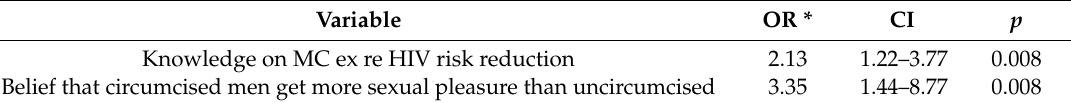
* Odds ratio = ratio between the two categories tested in each variable, controlling for other